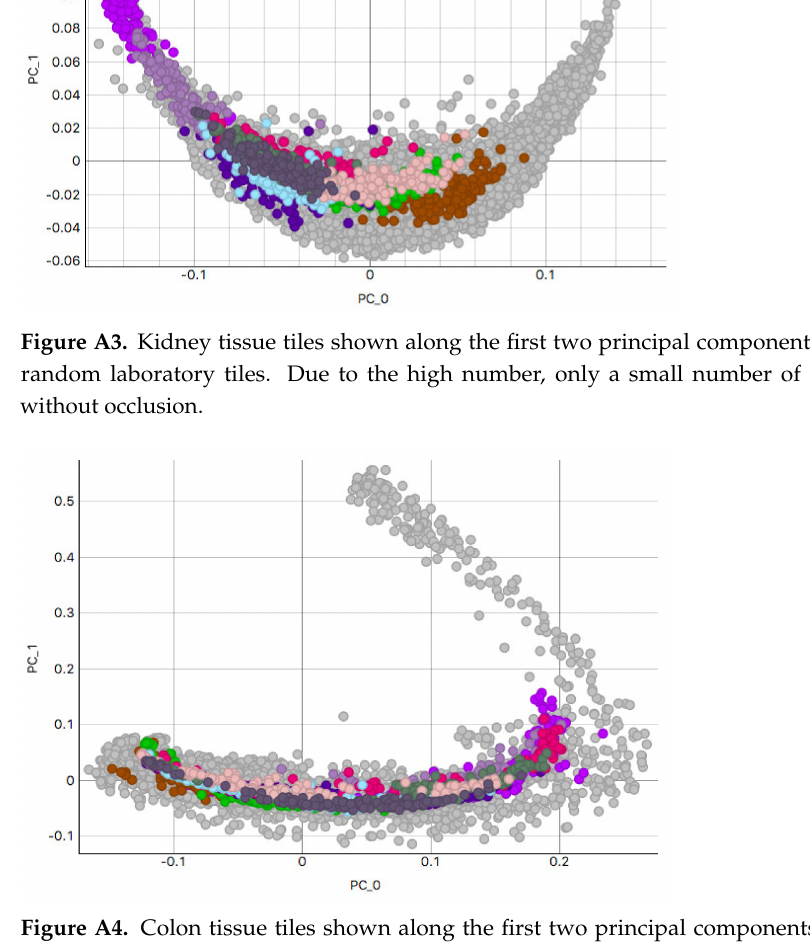
Figure A4. Colon tissue tiles shown along the first two principal components. Colors represent random laboratory tiles. Due to the high number, only a small number of tiles can be shown without